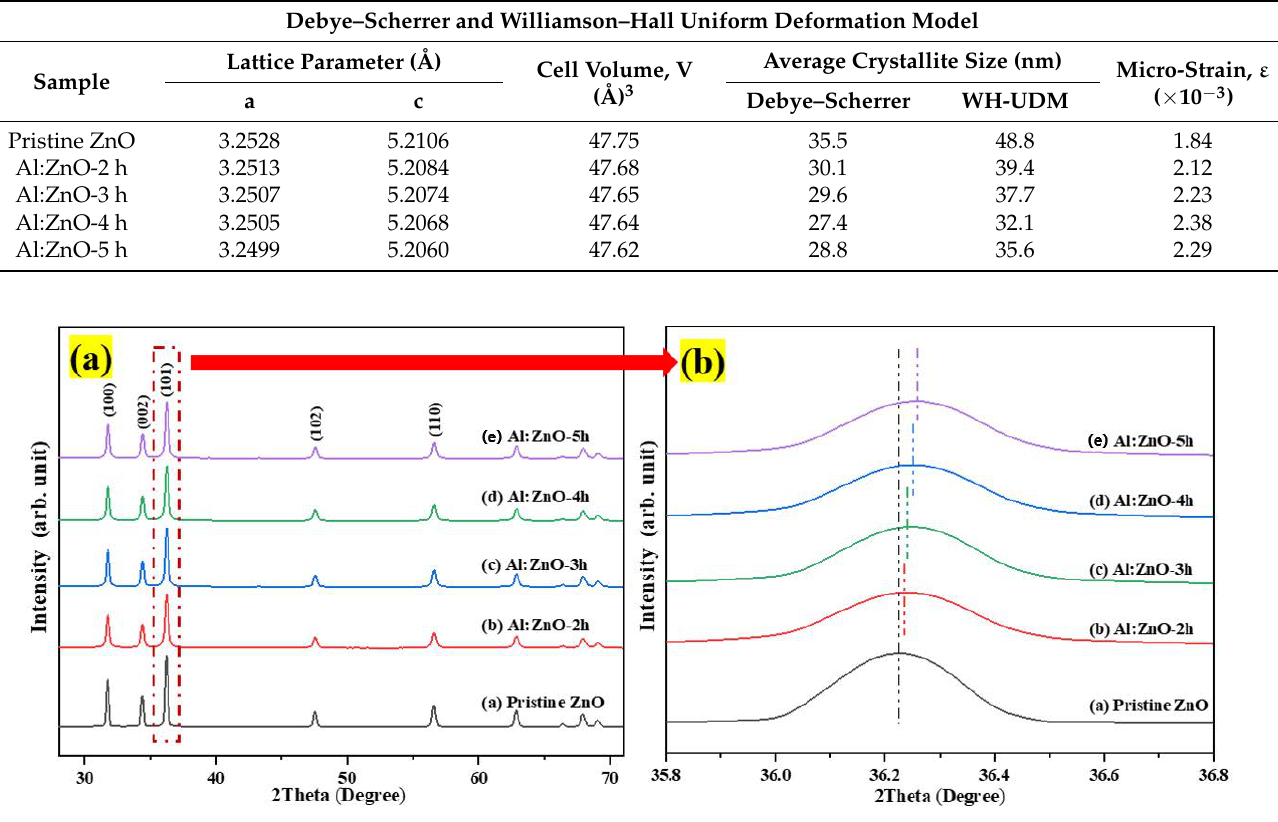
Table 1. Lattice parameters, average crystallite size, cell volume, and micro-strain for the pristine ZnO and Al:ZnO nanostructures calculated using the Debye–Scherrer method and Williamson–Hall uniform deformation model (WH-UDM).